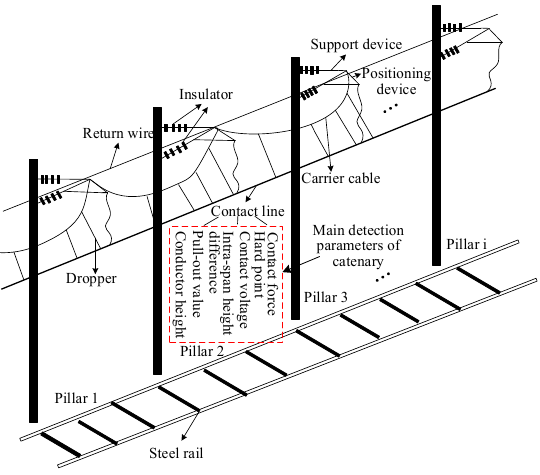
Figure 1. Catenary’s primary composition and detection capabilities.